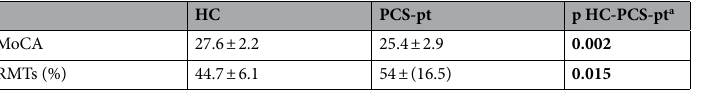
Table 2. Mann Whitney analysis for comparing MoCA-scores and RMT, between PCS-pt and HC. MoCA montreal cognitive assessment, RMTs resting motor thresholds, pt patients, HC healthy controls, PCS post COVID-19 syndrome. Significant values are in [bold]. a Both comparisons remained significant after Benjamini–Hochberg adjustment.